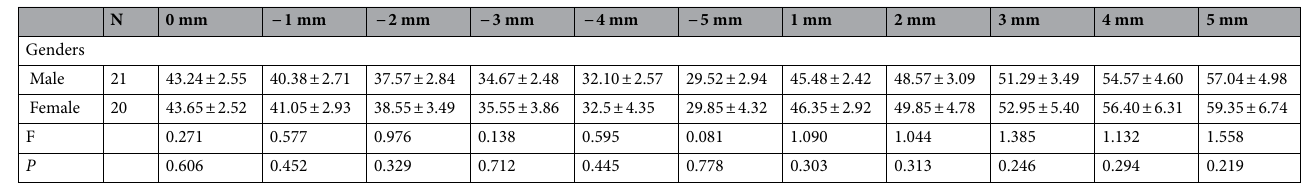
Table 2. The comparison of cup’s inclination in different genders of normal developmental hips (x ±